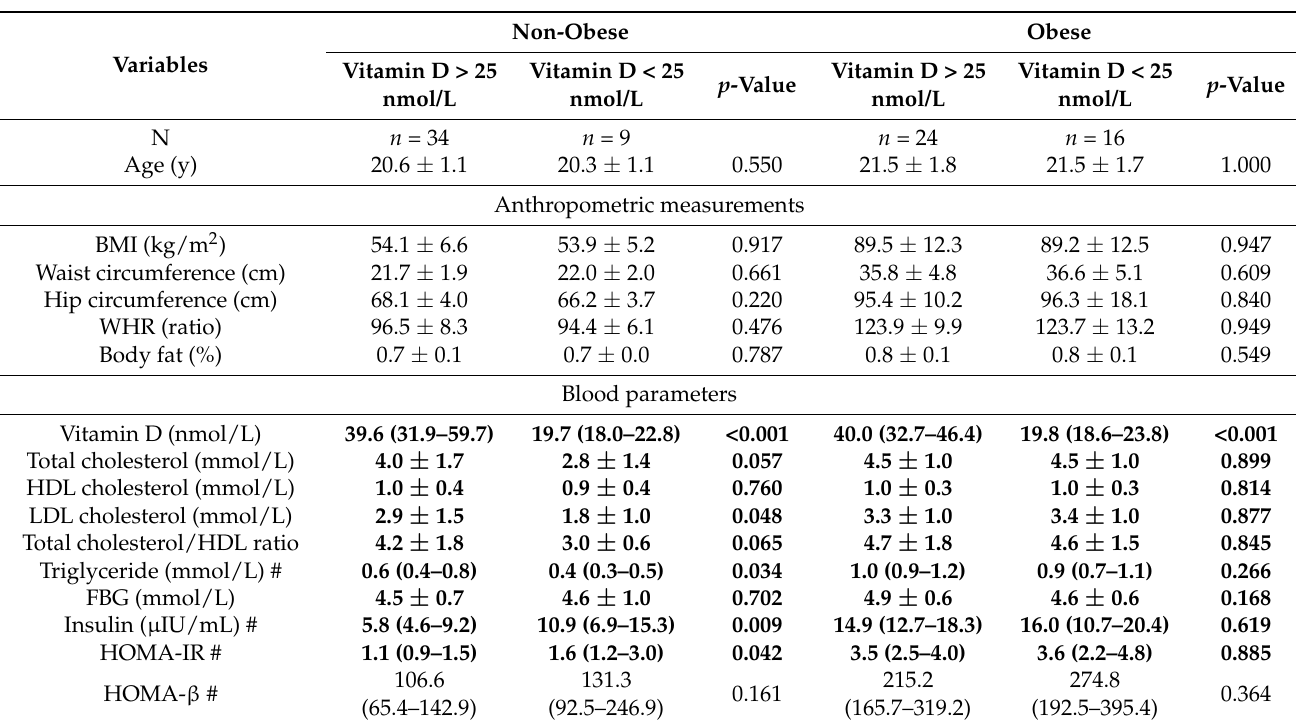
Table 1. Anthropometric and biochemical parameters of participants according to body mass index and vitamin D status 1